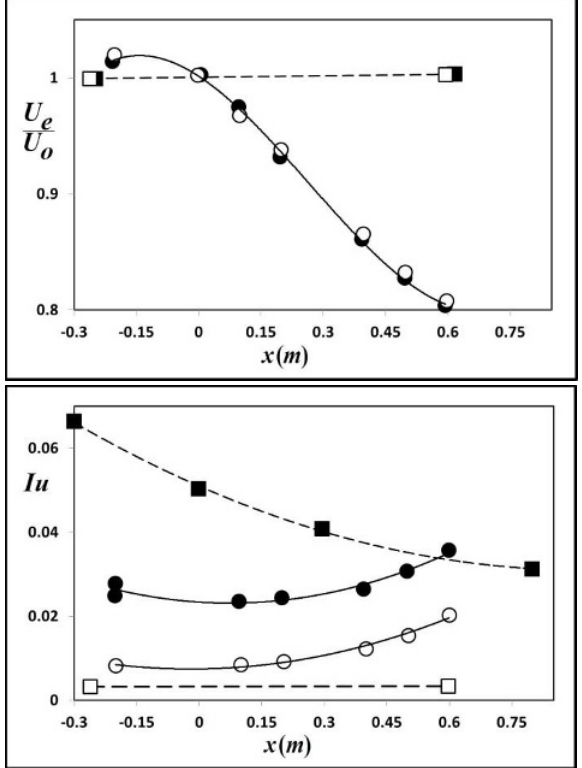
Fig. 2. Distributions of the dimensionless free stream mean velocity U e /U 0 and the intensity Iu of the longitudinal component of turbulent velocity fluctuations in free stream; zero pressure gradient (squares), decelerated flow (circles); empty symbols - natural turbulence level, black symbols - grid turbulence.